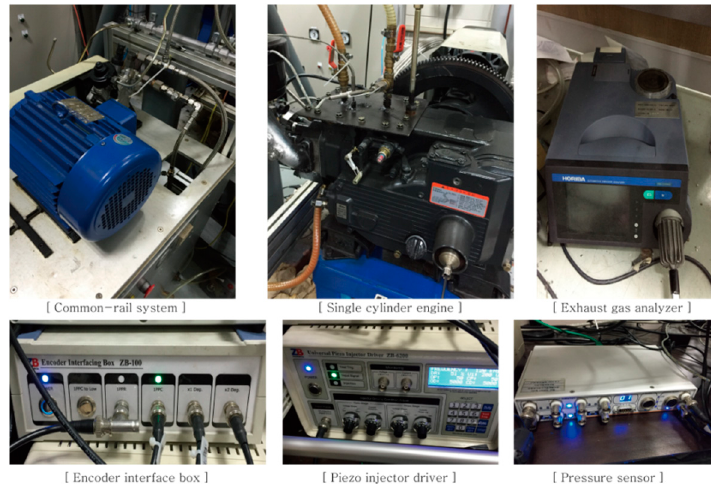
Figure 6. Experiment system of single-cylinder diesel engine. Table 5. Main specifications of the single-cylinder diesel engine.